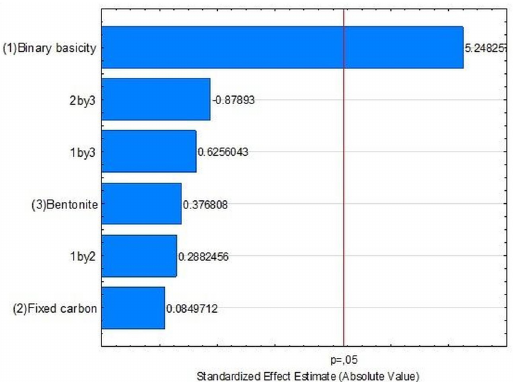
Figure 6. Pareto charts of the mechanical strength of the fired iron-ore pellets.